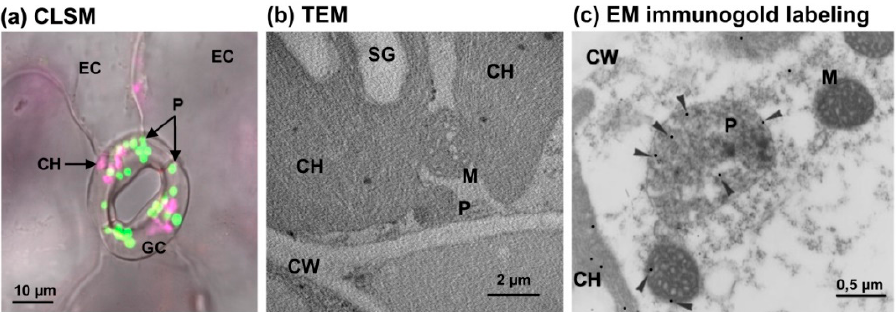
Figure 2. Images of leaf peroxisomes. ( a ) Confocal laser scanning microscope (CLSM) picture of the in vivo detection of peroxisomes (bright green) and chloroplasts (bright purple) in guard cells from Arabidopsis thaliana seedlings expressing the cyan fluorescent protein (CFP) fused to a peroxisome targeting signal 1 (PTS1). ( b ) Representative transmission electron microscope (TEM) micrograph of a thin section of a leaf from the halophyte Cakile maritima L. where the different subcellular compartments are observed (unpublished results). ( c ) Electron microscope (EM) immunocytochemical localization of NADP-isocitrate dehydrogenase (NADP-ICDH) in pea ( Pisum sativum L.) leaves. Arrowheads indicate 15-nm gold particles. Reproduced with permission from [25]. Copyright American Society of Plant Biologists. CH, Chloroplast. CW, cell wall. EC, epidermal cells. GC, guard cells. M, mitochondrion. P, peroxisome. SG, starch granule.